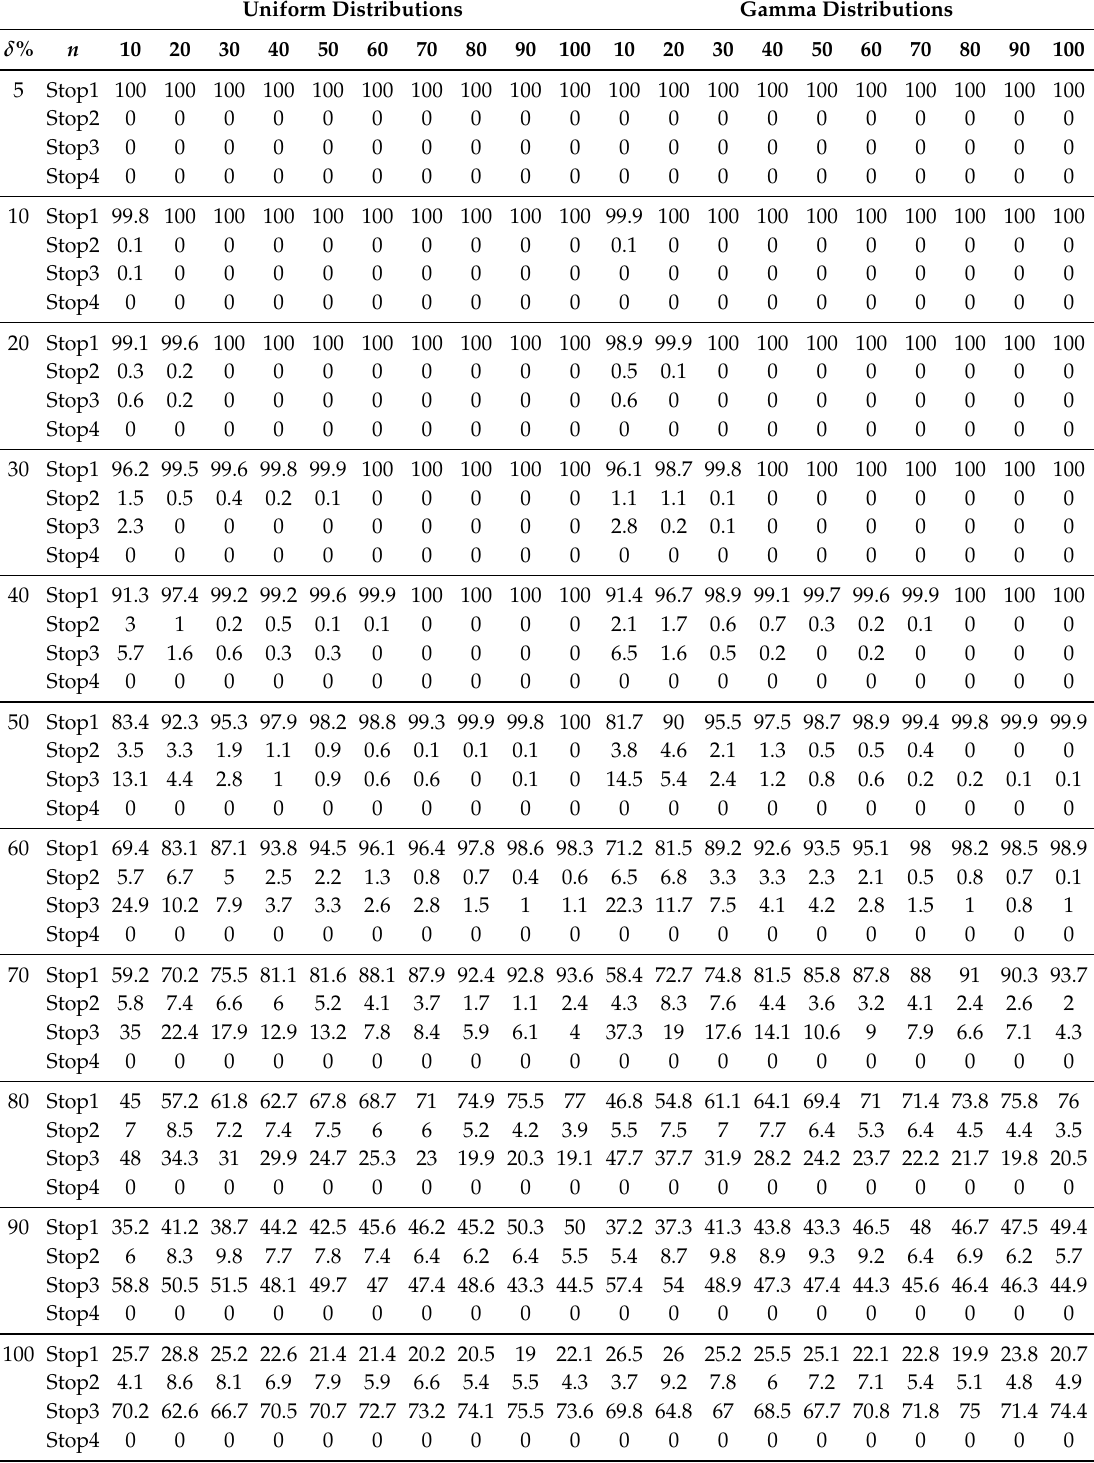
Table A5. Computational results for randomly generated instances with the ratio 0%:0%:50%:50% of the numbers of jobs in the subsets J 1 , J 2 , J 1,2 and J 2,1 of the job set J